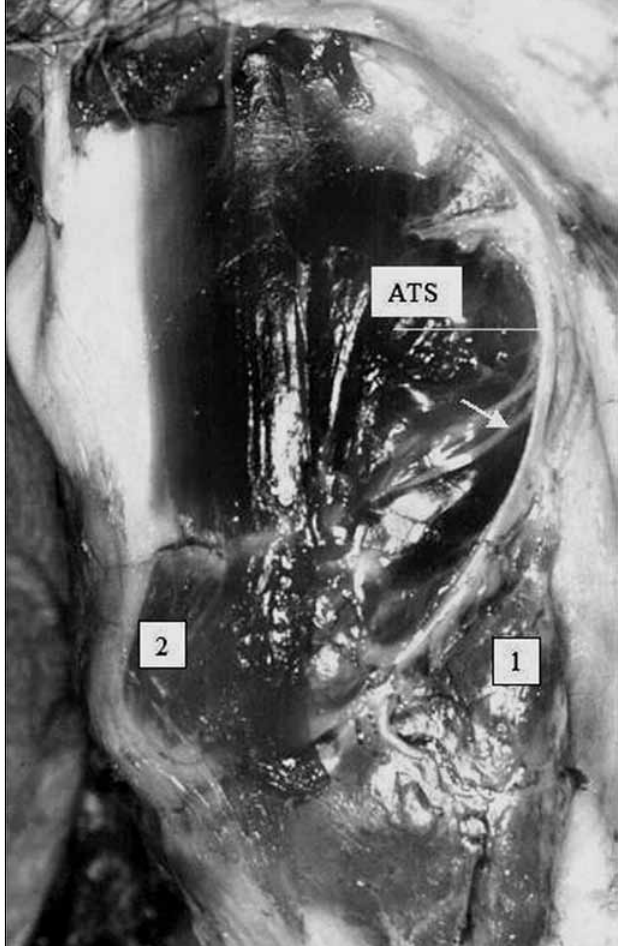
Figure 6. Left lateral view of the neck at the larynx, showing the external laryngeal nerve (white arrow) crossing the superior thyroid artery. Key: (1) tip of the left superior pole of the thyroid gland; (2) left cricothyroid muscle; SLN, superior laryngeal